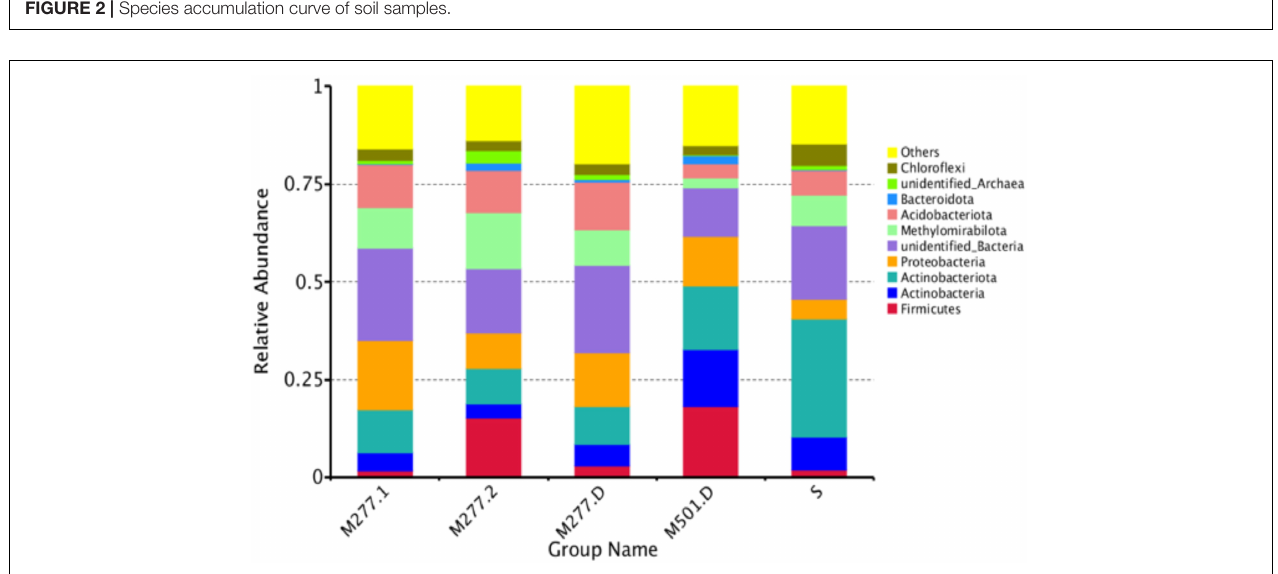
FIGURE 2 | Species accumulation curve of soil samples.